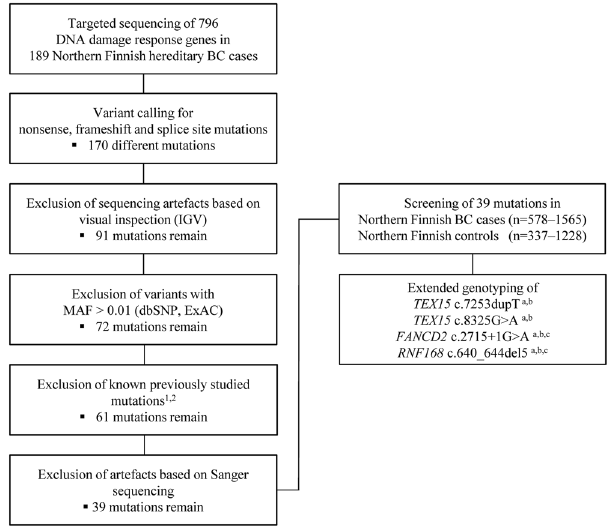
Figure 1. Workflow of the study. Targeted sequencing of 796 DDR genes was performed in 189 Northern Finnish breast cancer patients with indication of hereditary disease susceptibility. Analysis focused on rare mutations likely resulting in truncated protein products. After filtering steps, 39 mutations were genotyped in the Northern Finnish case and control cohorts. Extended genotyping of four mutations were performed in Finnish breast cancer and control cohorts from Helsinki a , Tampere b and Kuopio c regions. 1 Supplementary Table S2, 2 MCPH1 c.904_916del reported in Mantere et al . 12 . ExAC: Exome Aggregation Consortium